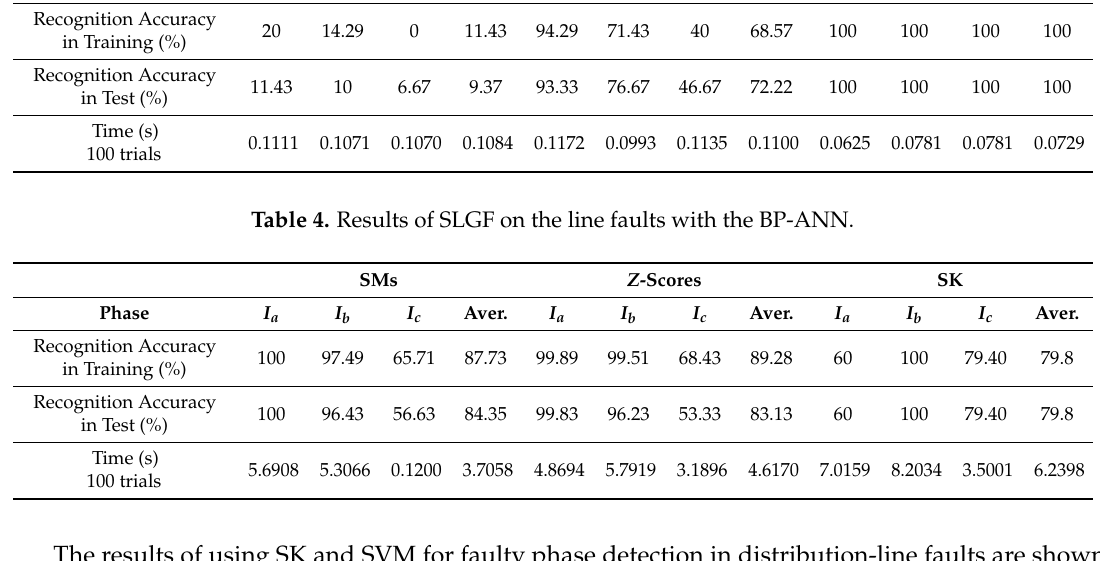
Table 3. Results of SLGF on the line faults with the k -nearest neighbors ( k -NN) ( k = 1). SMs Z -Scores SK Phase Aver.